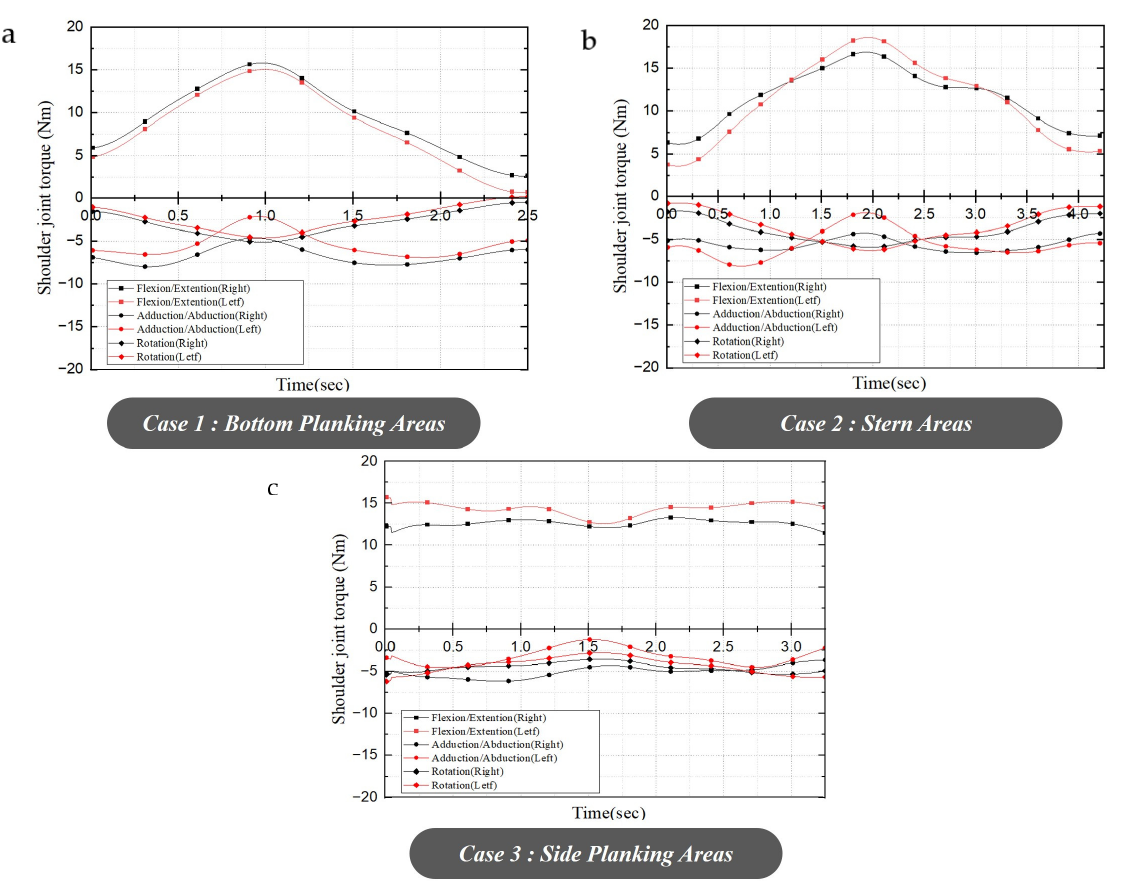
Figure 4. Changes in shoulder joint torque at motion capture: ( a ) bottom planking areas; ( b ) stern areas; ( c ) side planking areas. Table 1. Joint angle and joint torque results of various working motions at motion capture.